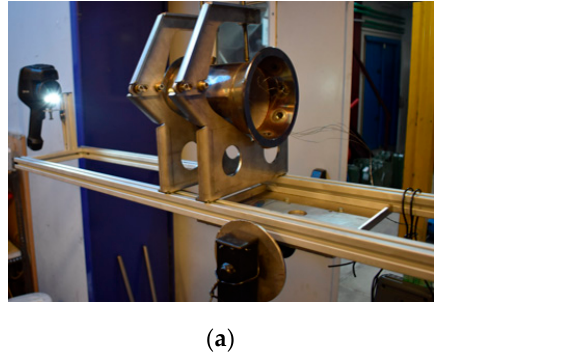
Figure 2. Measurements performed at various inclinations. ( a ) Horizontal; ( b ) 45° inclination.